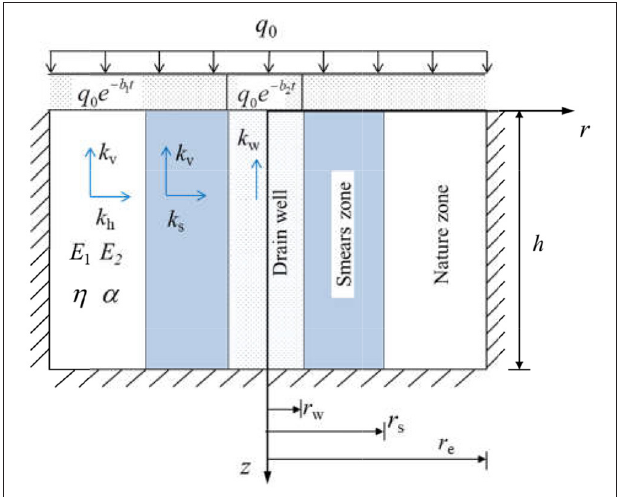
FIGURE 1 | The consolidation system of vertical drains under continuous drainage boundary conditions.